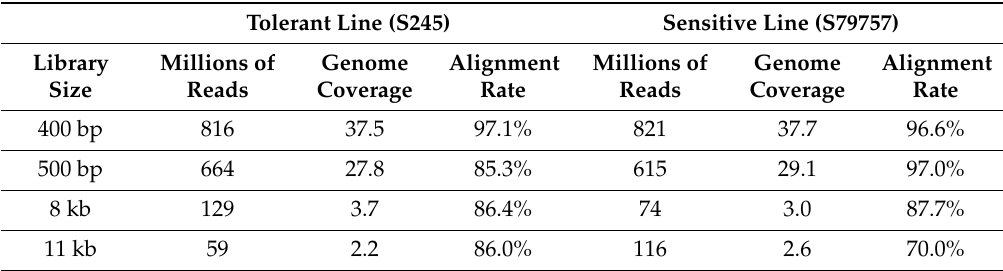
Table 1. The alignment results for Illumina libraries in glyphosate-tolerant and glyphosate-sensitive Zea mays lines.